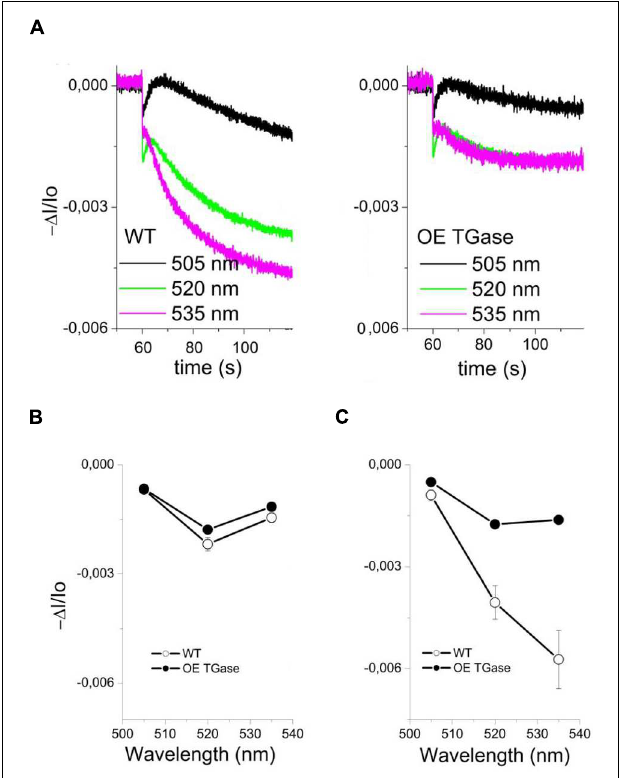
FIGURE 6 | Study of light scattering in intact WT and OE TGase leaves (kinetics, spectrum). (A) Typical absorbance changes after cessation of actinic light (490 µ mol photons m − 2 s − 1 ) and decay of the steady state signal in WT and OE TGase. The signal at 535 nm shows that OE TGase plants have marginal activation of its photoprotective mechanism. Absorbance changes at 535 nm are correlated with the qE response (see also low values of qE in Figure 3B ). (B) The spectrum of pmf showing a clear peak at 520 nm both for WT and OE TGase. (C) The spectrum of light scattering showing a normal peak near 535 nm for WT, but a much smaller and more broad peak for OE TGase.